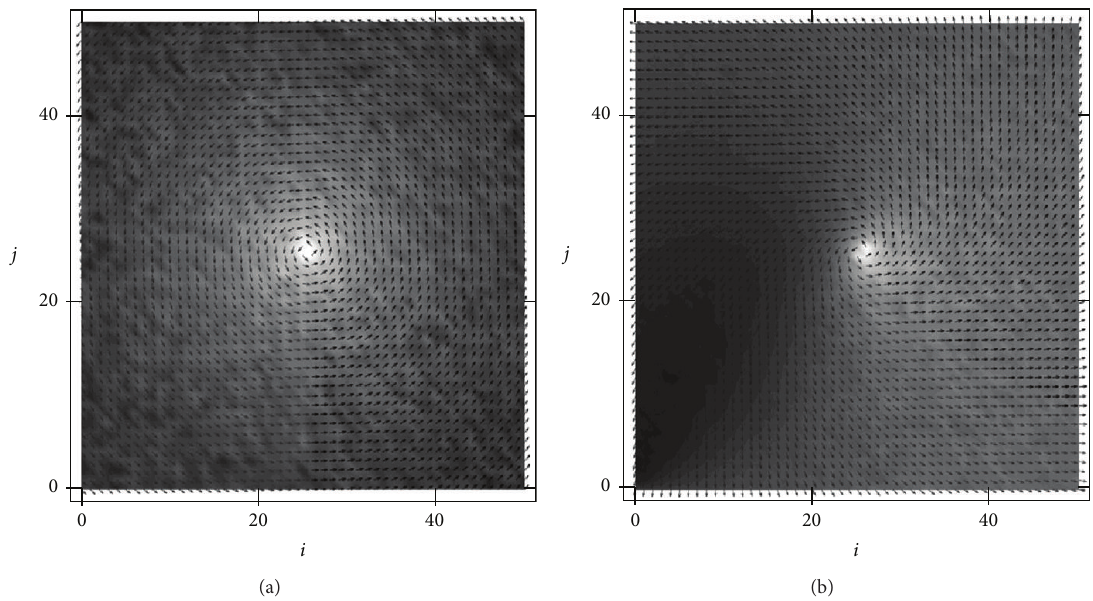
Figure 8: Limiting orientation of particles in an axial shear field on the lattice plane (𝑆 1 ,𝑆 2 ) 𝑖,𝑗 and levels of deformation work 𝐴 𝑖,𝑗 = 𝑆 𝑖,𝑗 ⋅ ℎ (the dark region corresponds to minimal stretching stresses). (a) Radial component is absent; (b) radial component is present.